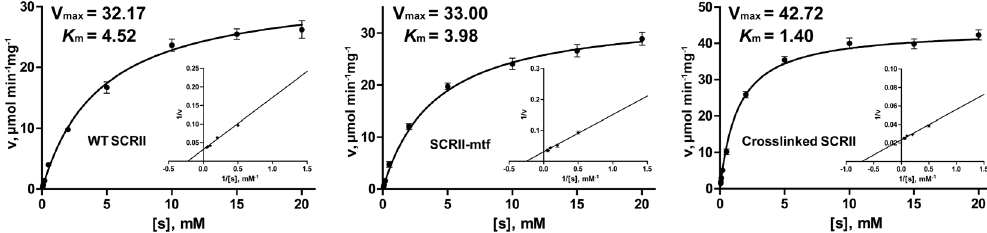
Figure 6. Michaelis-Menten and Lineweaver-Burk plots of WT SCRII, SCRII-mtf and Crosslinked SCRII toward 2-HAP. Each value was calculated depending on three independent measurements and all standard errors of fits were not more than 5%. The data obtained were fitted to the function v = V max [s]/( K m + [s]).